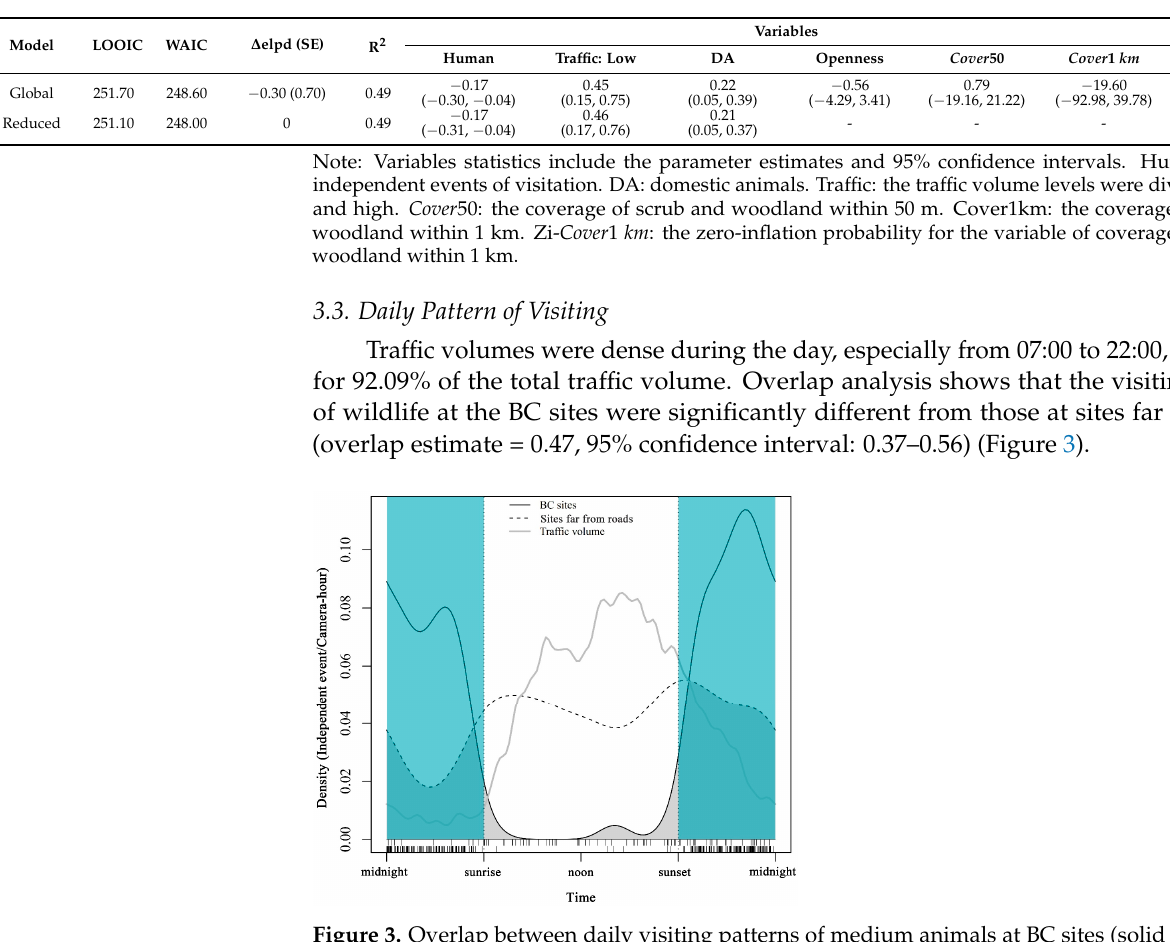
Table 2. The LOOIC and R 2 for zero-inflated Poisson (ZIP) GLMM. WAIC results were consistent with LOOIC. Reduced models include the set of predictors that were considered important in the global models (95% CI did not cross 0). The difference between each model and the best-fit model is shown as ∆ elpd (expected log predictive density) with standard error (SE).